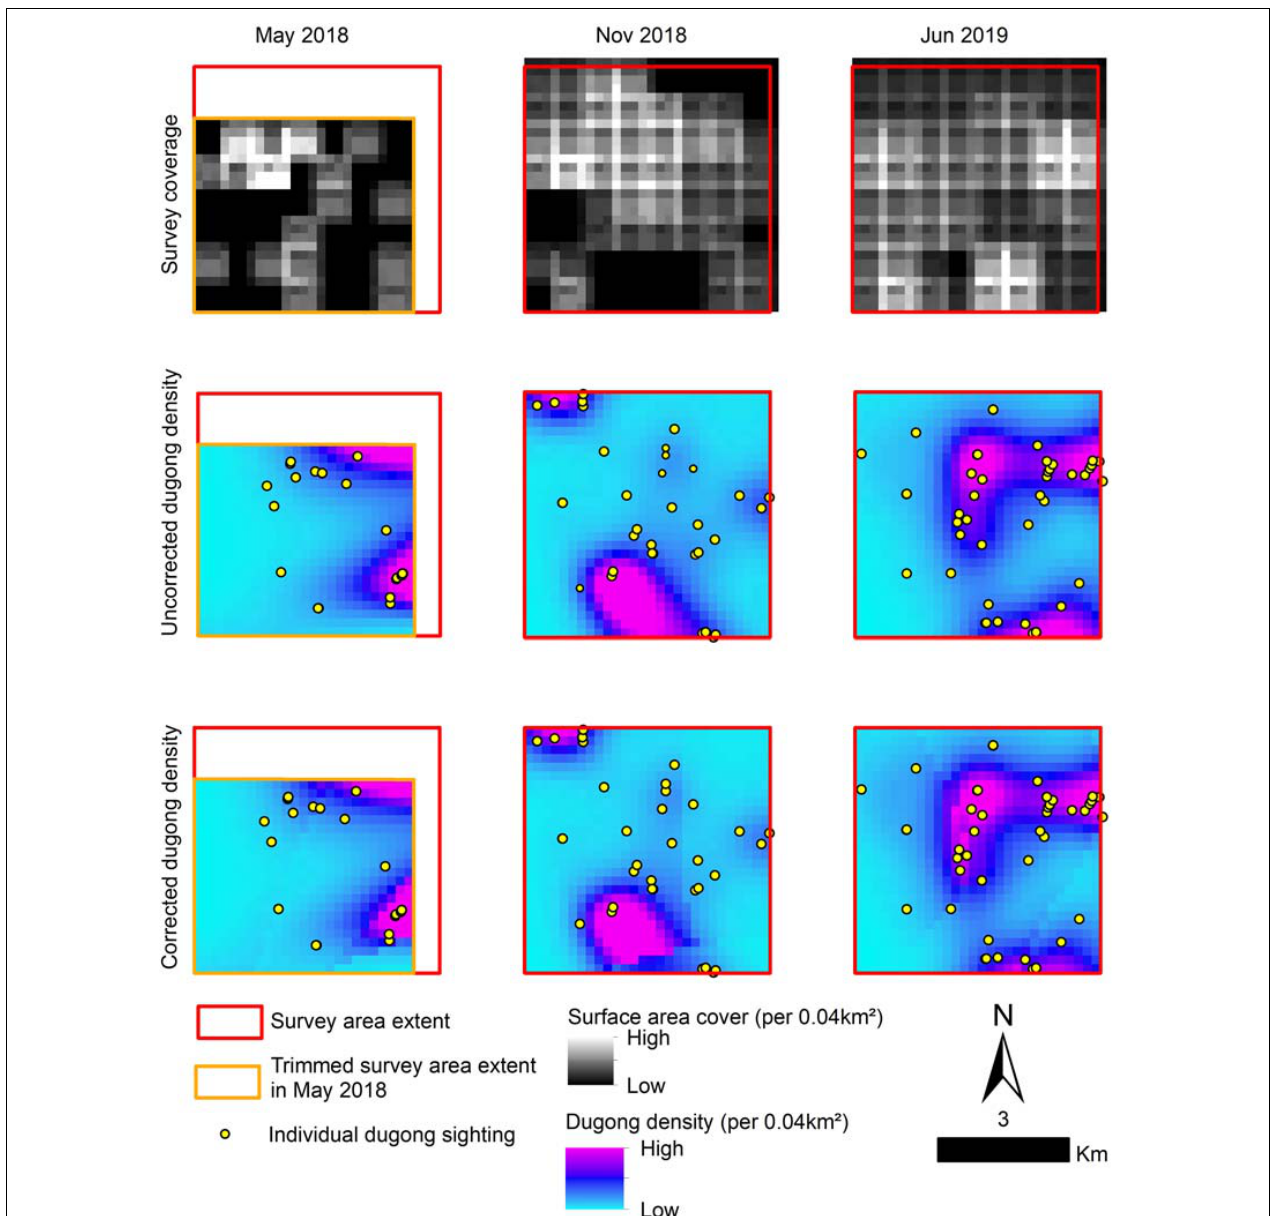
FIGURE 4 | Raw dugong sightings overlaid with spatially explicit, uncorrected and availability corrected, dugong density surface models for each of the three field seasons.